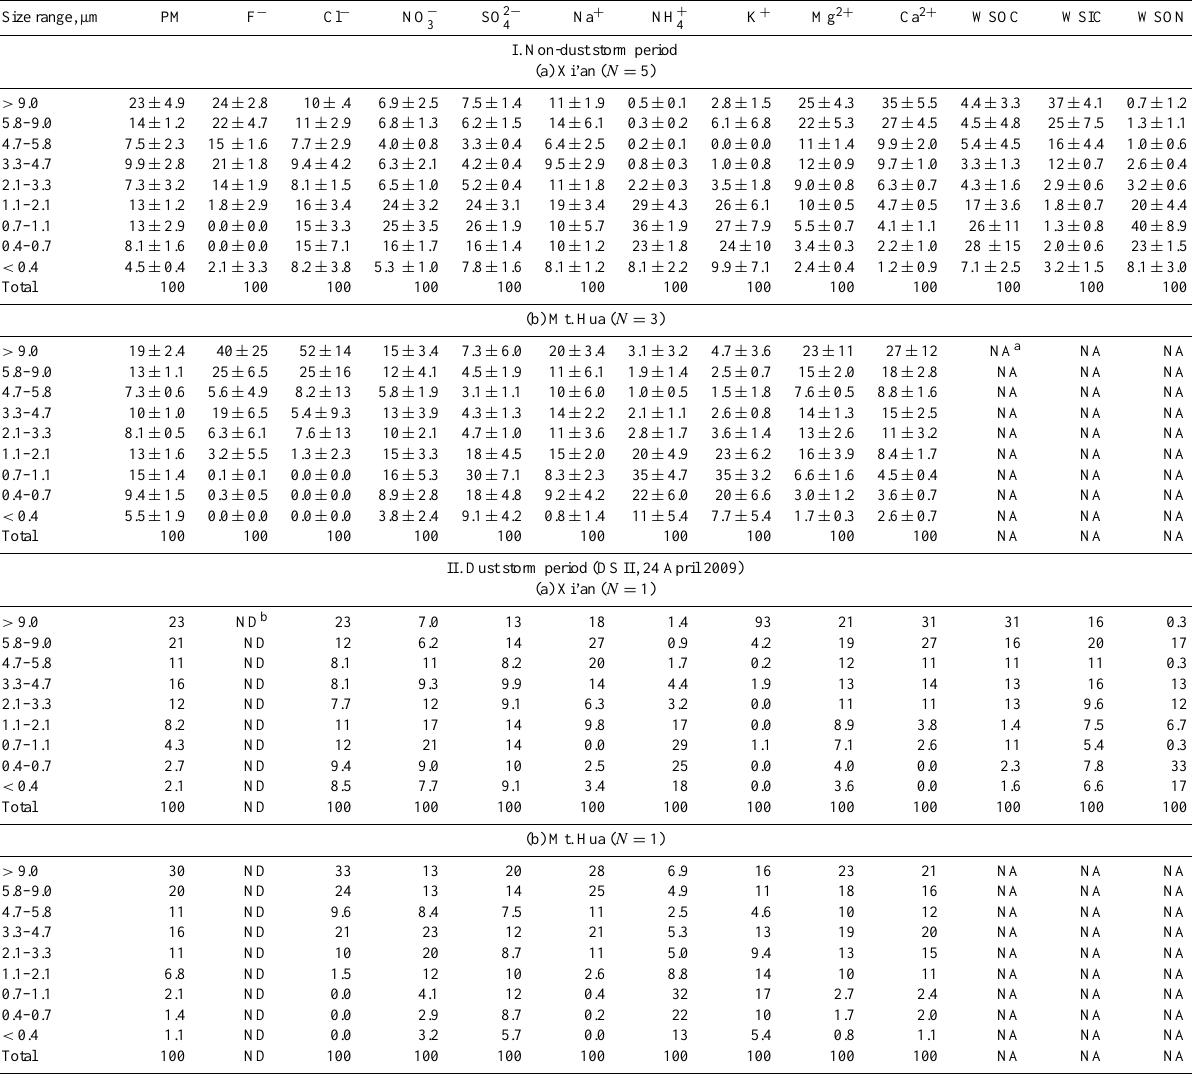
Table 4. Concentration percentages (%) of particle mass (PM), inorganic ions, water-soluble organic carbon (WSOC), water-soluble inor- ganic carbon (WSIC) and water-soluble organic nitrogen (WSON) in the size-resolved aerosols from Xi’an and Mt. Hua during the spring of 2009. Size range, µm